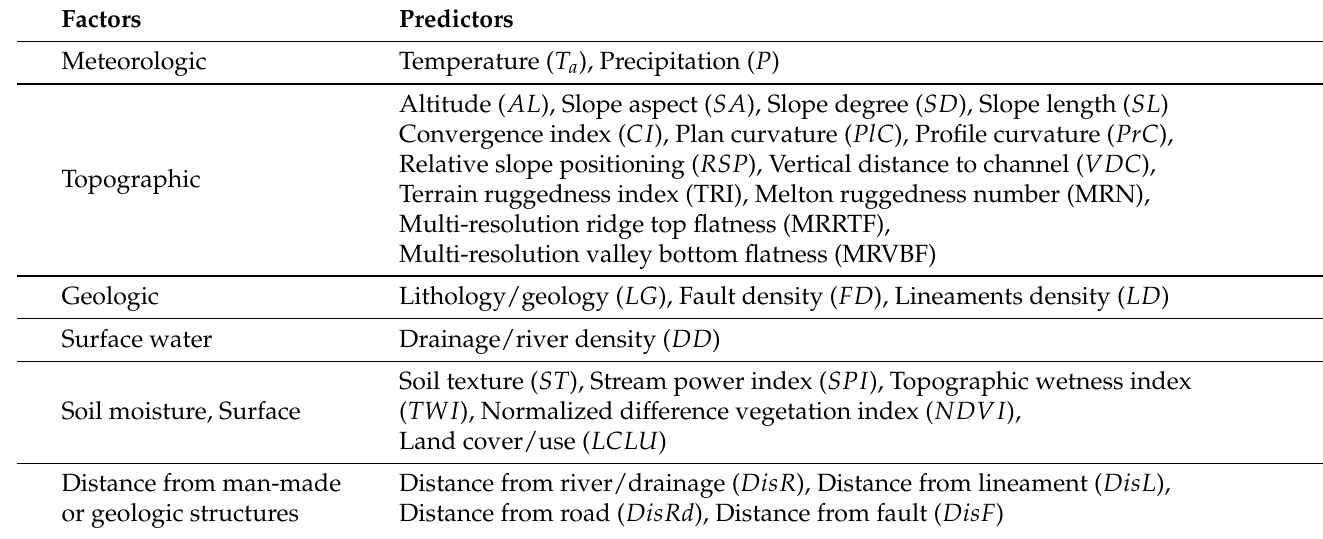
Table 2. Factors and predictors used in IAI-based groundwater potential